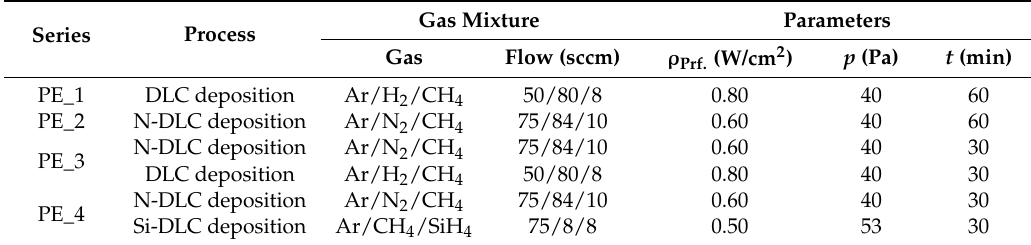
Table 1. Technical parameters applied in surface modification of LDPE (low-density polyethylene) substrates using the RF CVD (radio frequency chemical vapor deposition)